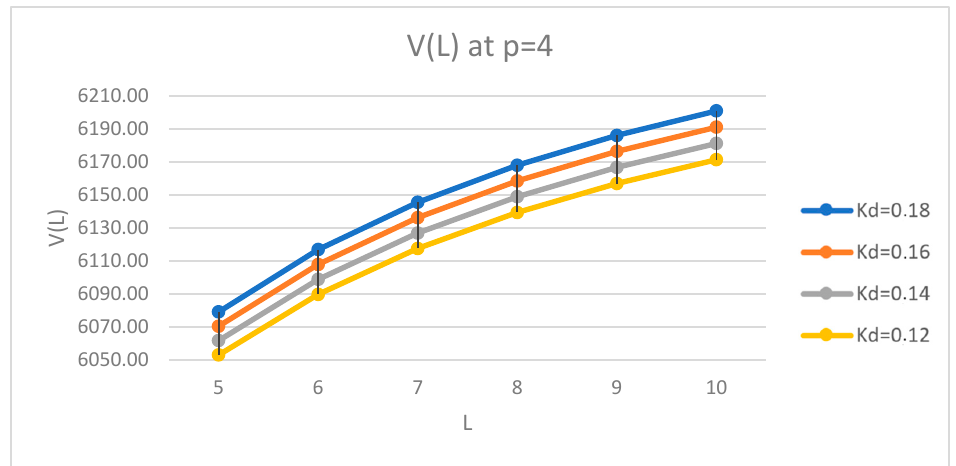
Figure 13. Dependence of the company capitalization, V, on leverage level L at different debt cost k d (12%; 14%; 16%; 18%) and fixed frequency of payments of tax on profit p = 4 (larger scale).